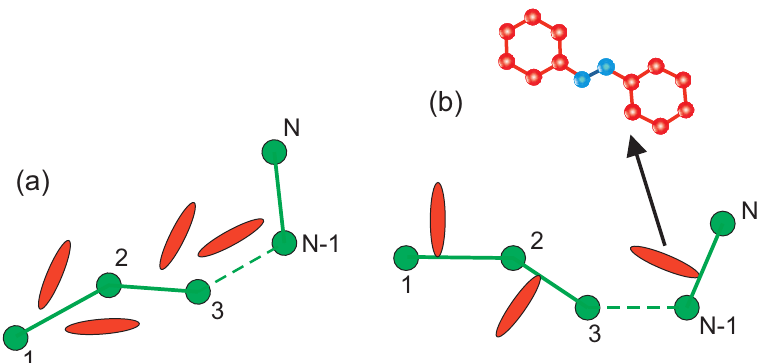
Figure 3. Azo-dyes embedded in the polymer matrix ( a ) and attached to BFM chain ( b ).